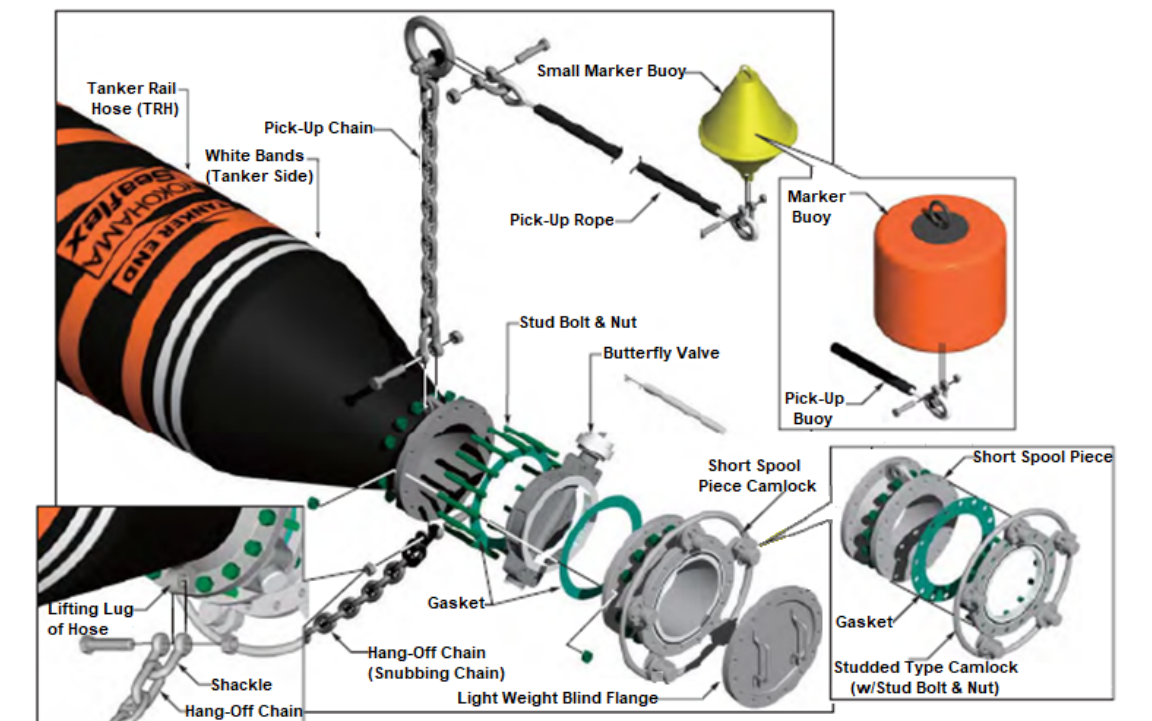
Figure 3. Tanker end gear assembly for floating hose line configured using Yokohama’s Seaflex hose (adapted from Yokohama Manual).